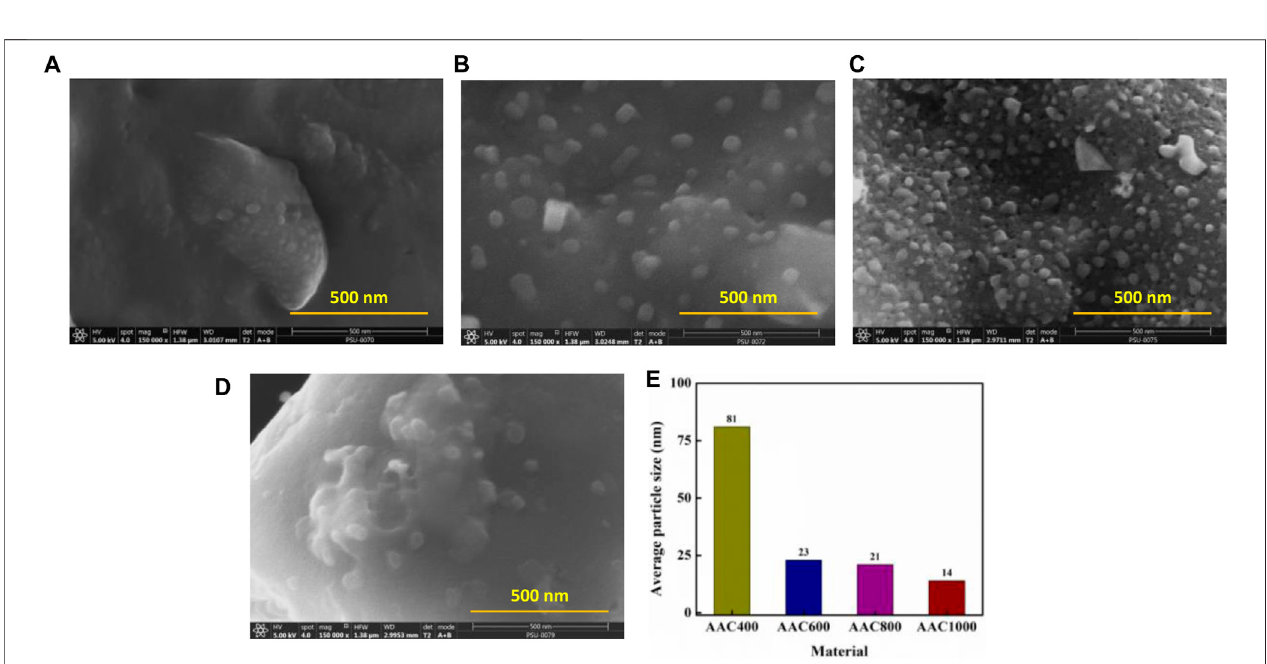
FIGURE 2 | FESEM images of AAC400 (A) , AAC600 (B) , AAC800 (C) , and AAC1000 (D) . Average particle size of AACs obtained from TEM analysis (E) .